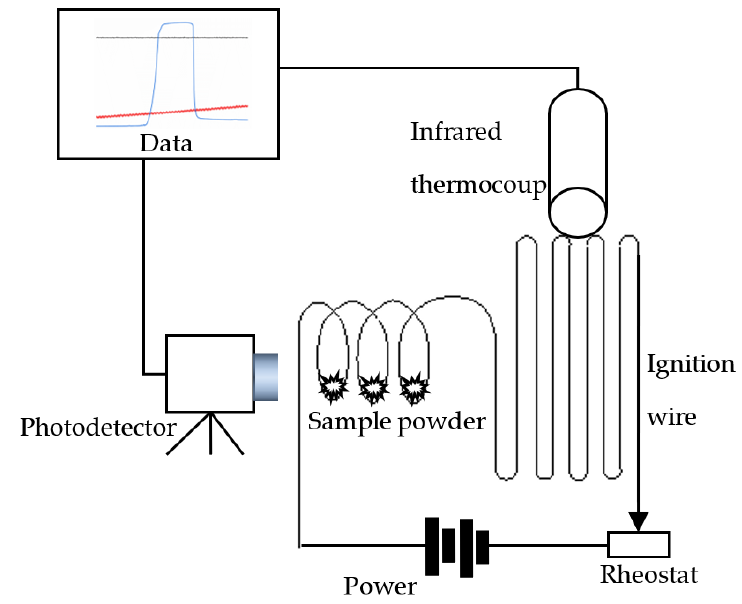
Figure 1. The sketch of the ignition temperature tester. The laser ignition system consisted of three parts: laser igniter, combustion chamber, and data acquisition device, as shown in Figure 2. The laser igniter included three main parts: fiber-coupled semiconductor laser, laser power supply, and an optical coupler. The